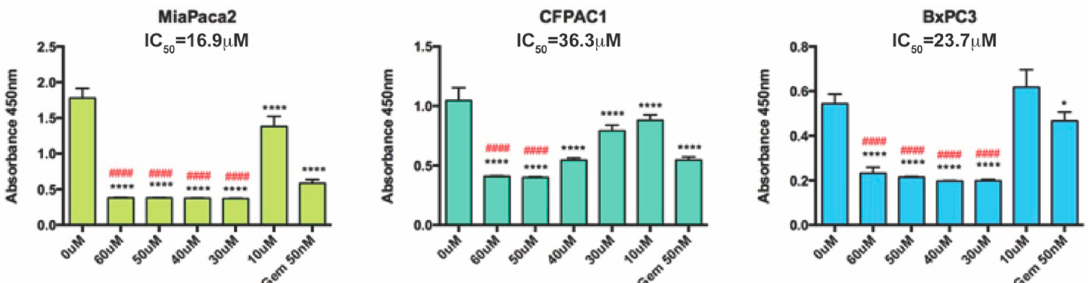
Figure 2. After 48 h treatment, derivative BisP4 had a statistically significant reduction in cell viability from all concentrations, except for 10 µ M treatment on BxPC3 cells. Results are mean absorbance ± SD, n = 6. Values for variance ( p ) between control versus treatment and gemcitabine versus treatment are respectively denoted by symbols ****, #### , p < 0.0001, ***, ### p < 0.001, **, ## p < 0.01, *, # p < 0.05, determined using a one-way ANOVA and Dunnett’s post-hoc test.